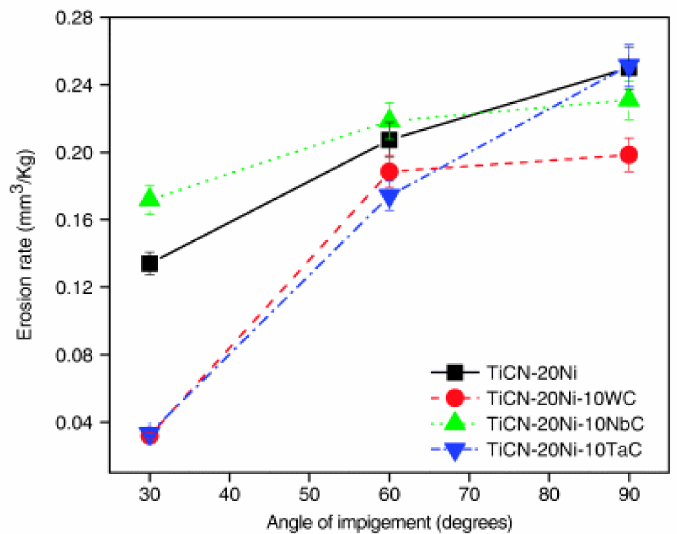
Figure 10. Erosion rate vs. impact angle for Ti(C 0.7 N 0.3 )-based cermets (erodent SiC with particle size ~66 µ m, mass flow rate 2.33 g/s)